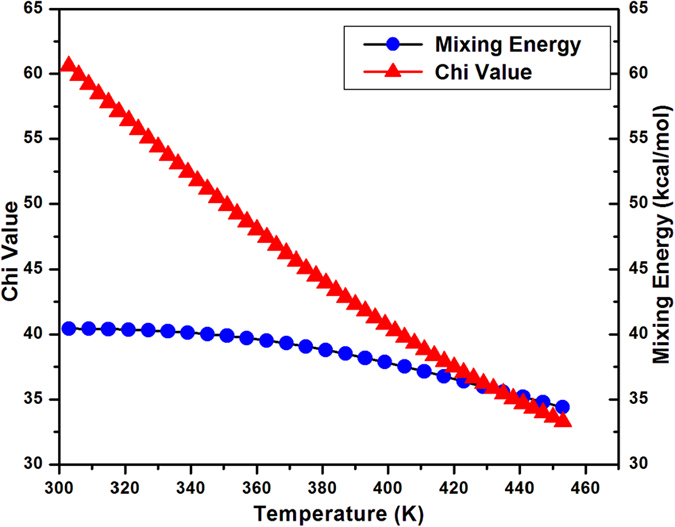
Computation of Thermodynamic Interaction Parameter (χ ) and Mixing Energy (Emix) via Materials Studio.